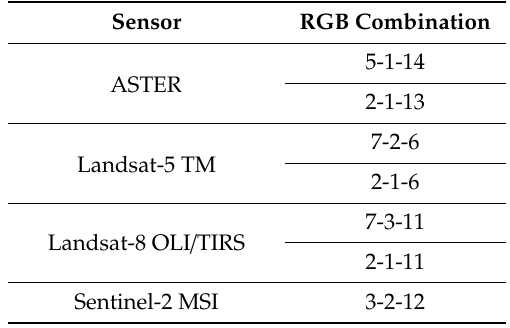
Table A1. Proposed RGB combinations for Li pegmatite detection [63].